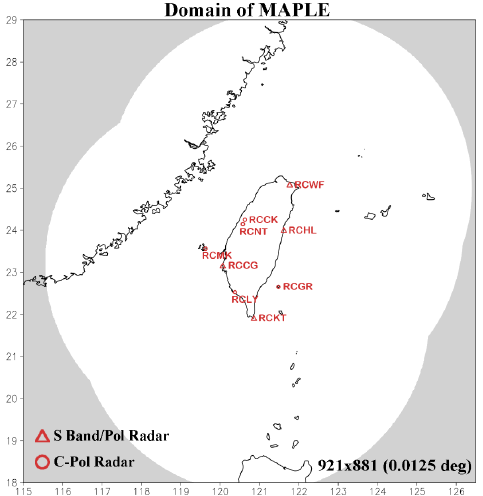
Figure 1. The simulation domain of the McGill Algorithm for Precipitation Nowcasting by Lagrangian Extrapolation (MAPLE) and the reflectivity coverage area (in white) of nine Doppler weather radars used by MAPLE. The domain has 921 × 881 horizontal grid points with 0.0125° spacing.